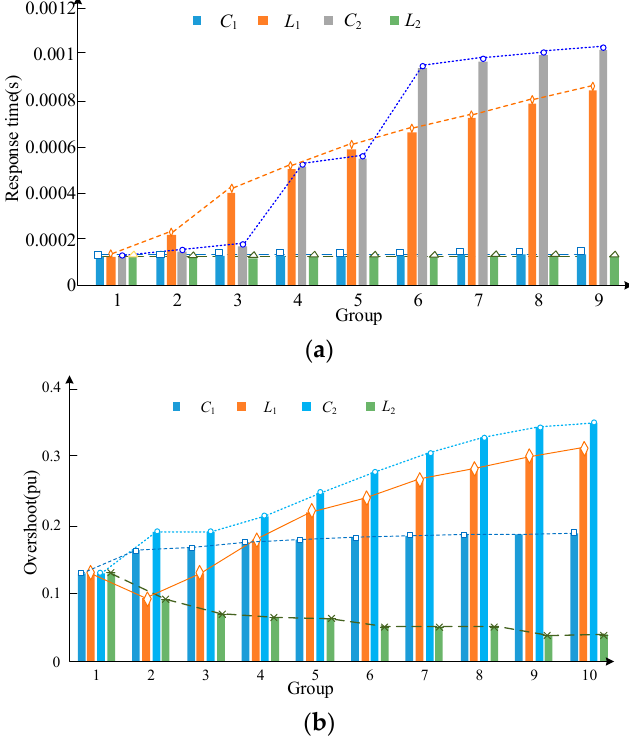
Figure 14. ( a ) Response time and ( b ) overshoot of the filter under different component parameters.